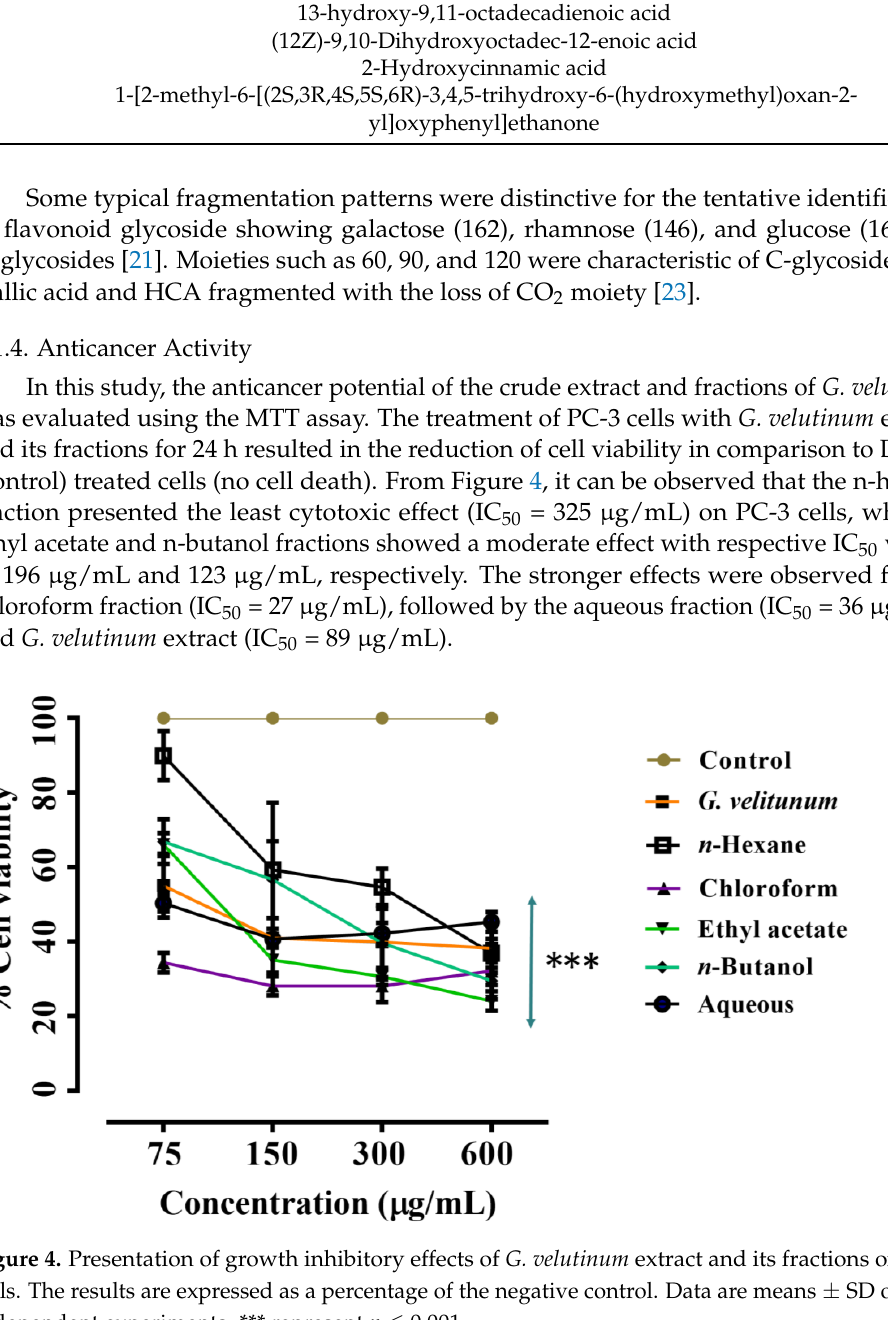
Figure 5 . Presentation of growth inhibitory effects of G. velutinum extract and its fractions on MCF- 7 cells. The results are expressed as a percentage of the negative control. Data are means ± SD of three independent experiments. * and *** represent p ≤ 0.05 and p ≤ 0.001, respectively.